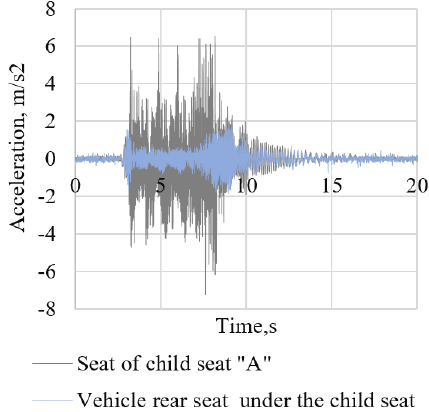
Figure 9: Vertical accelerations recorded on the seat A and ISOfix base (suspension in a raised position, the seat is loaded with a mass of 5 kg)